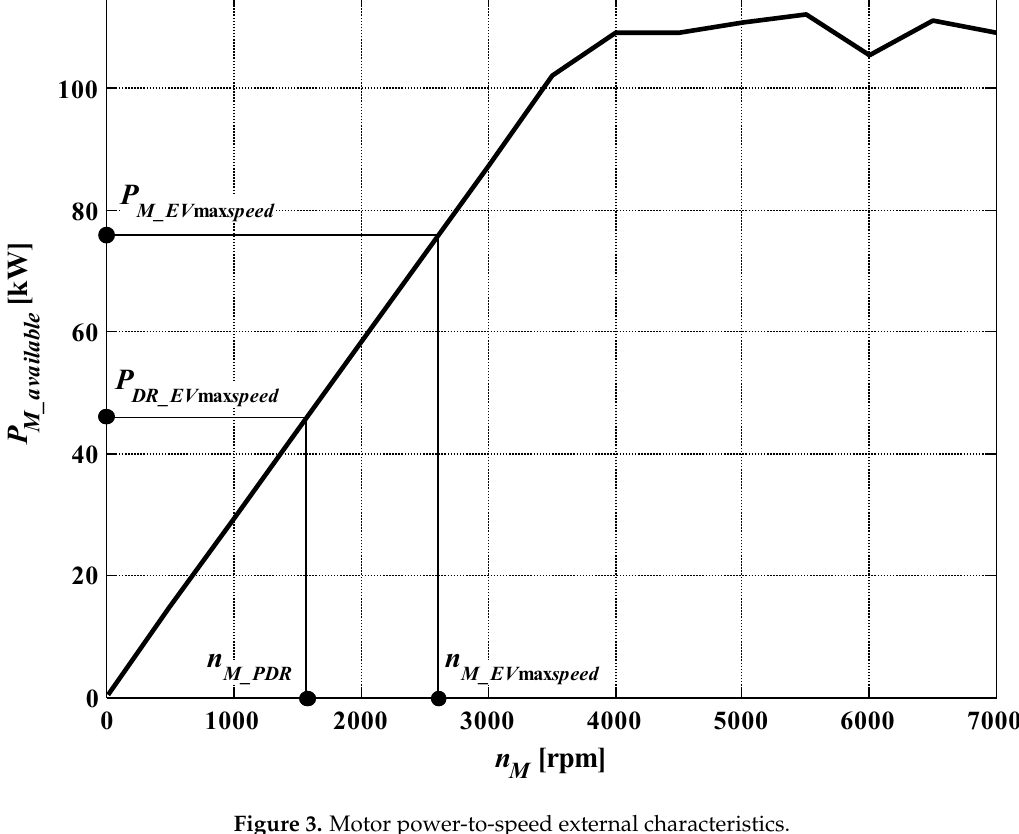
Figure 3. Motor power-to-speed external characteristics.